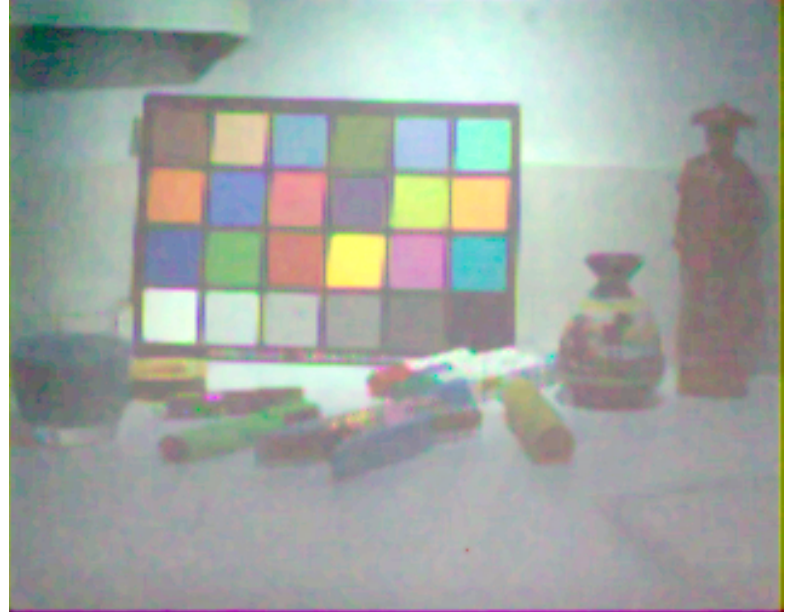
Figure 13. sRGB image of scene 1 computed according to a colorimetric calibration of the sensor. Color image is provided as Supplementary Materials in Figure